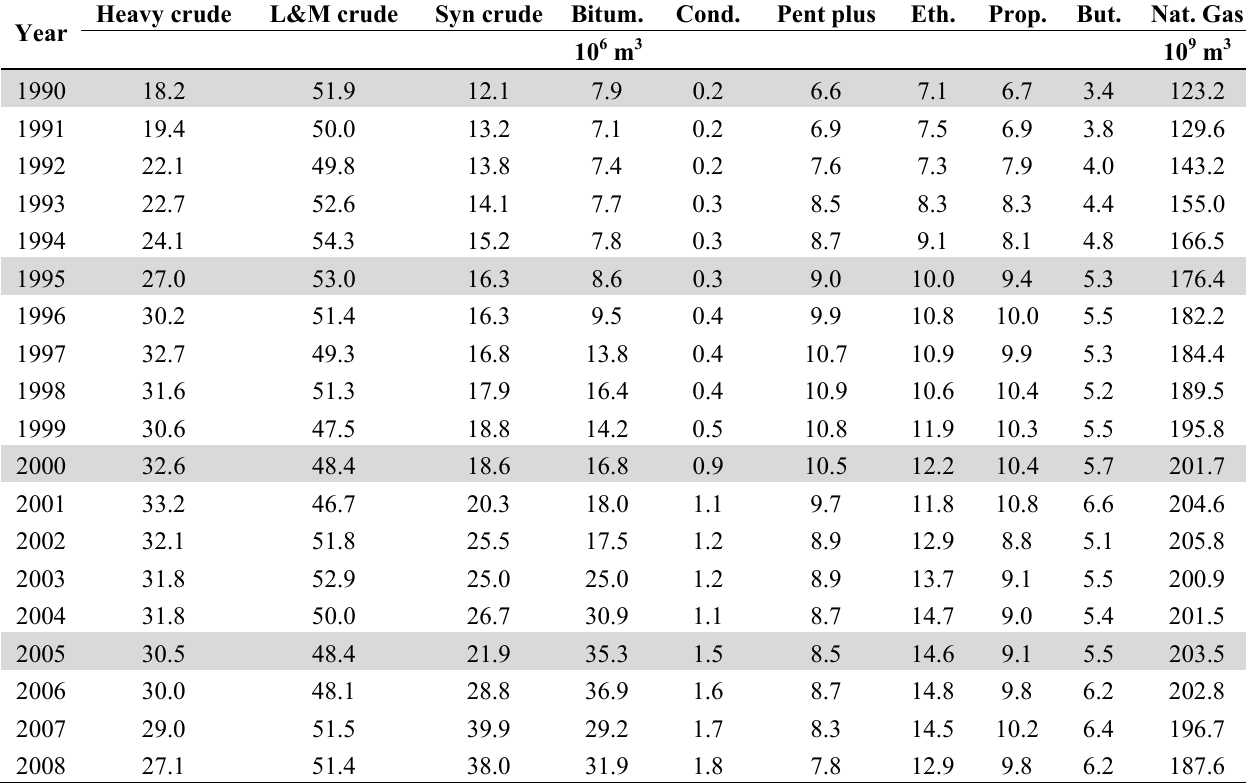
Table 1. Annual production of Canadian petroleum [31,32,35].